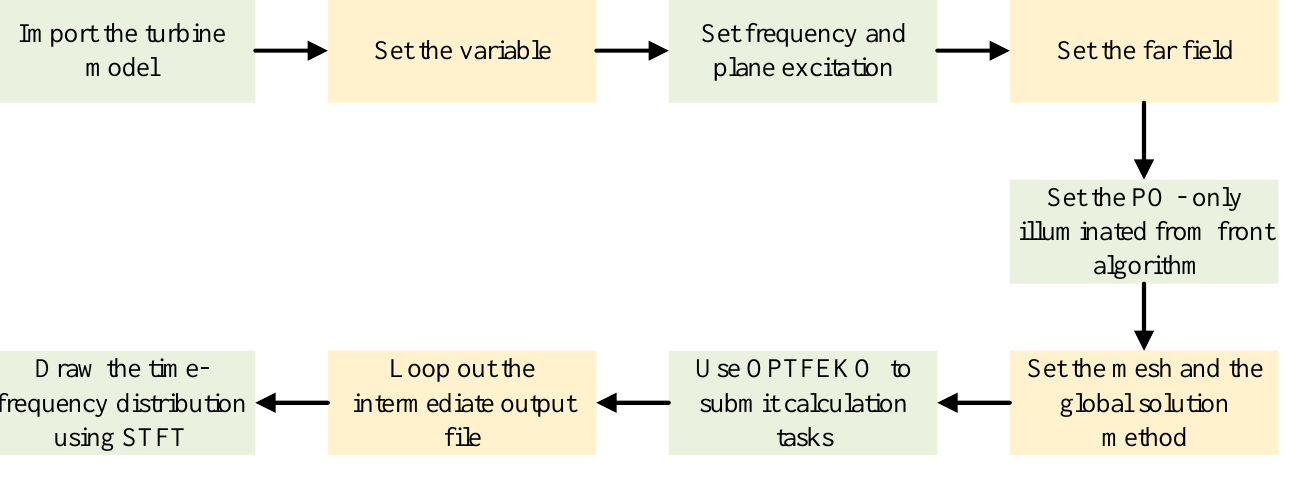
Figure 5. The flowchart of the turbine blade micro-motion simulation experiment.